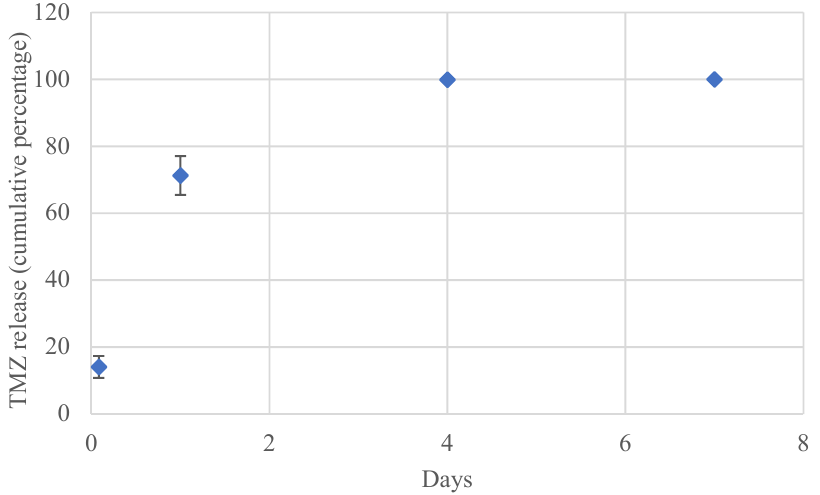
Figure 6. In vitro release of Temozolamide in acetate buffer of pH 3.5 at 37 °C. The amount of Temozolamide was calculated using HPCL. The percentage errors are calculated from an average of three observations.